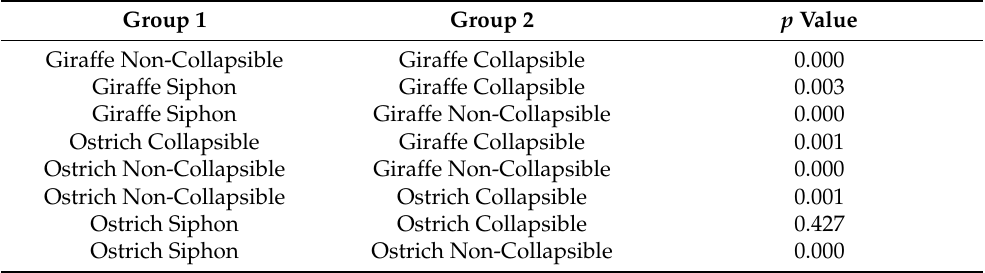
Table 4. Non-parametrical differences between groups are illustrated utilising the Pairwise Wilcox